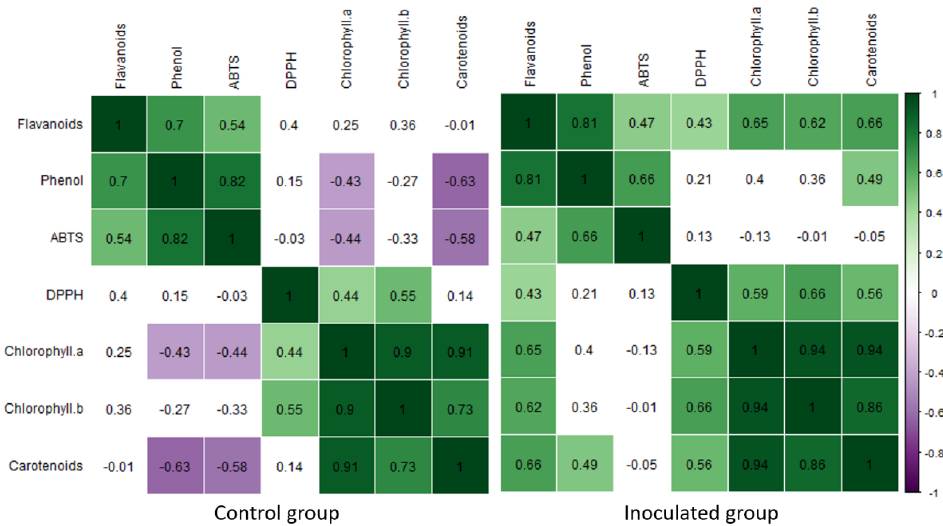
Figure 2. Correlation matrix for the data acquired after the 8th incubation week with Paenibacillus sp. ( right ) and their respective control groups ( left ), based on the Pearson correlation coefficient. Significant ( p ≤ 0.05) correlation coefficients are colored.